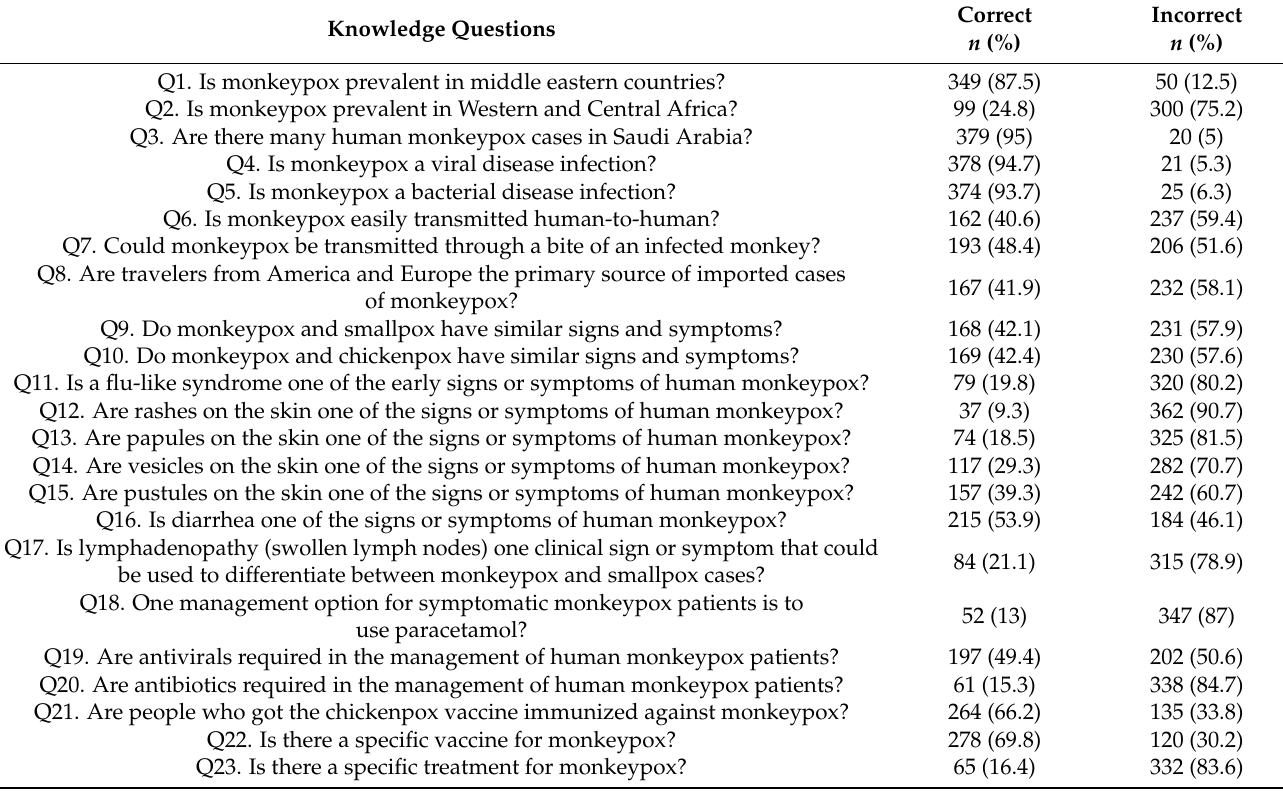
Table 2. Responses of physicians who participated in the study to the knowledge questions about the monkeypox virus ( n = 398).